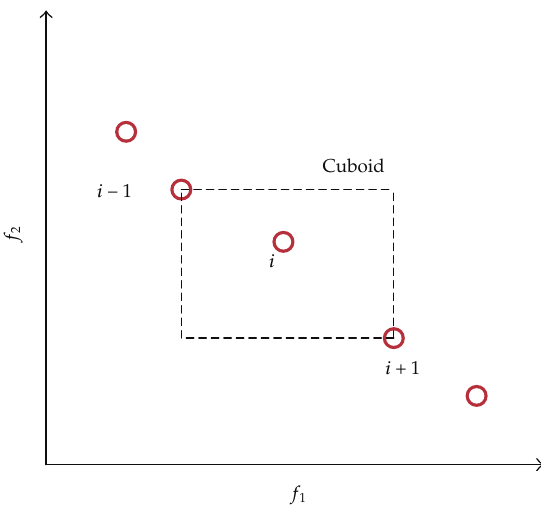
Figure 2: Crowding distance: Points are all nondominated solutions in the external archive.